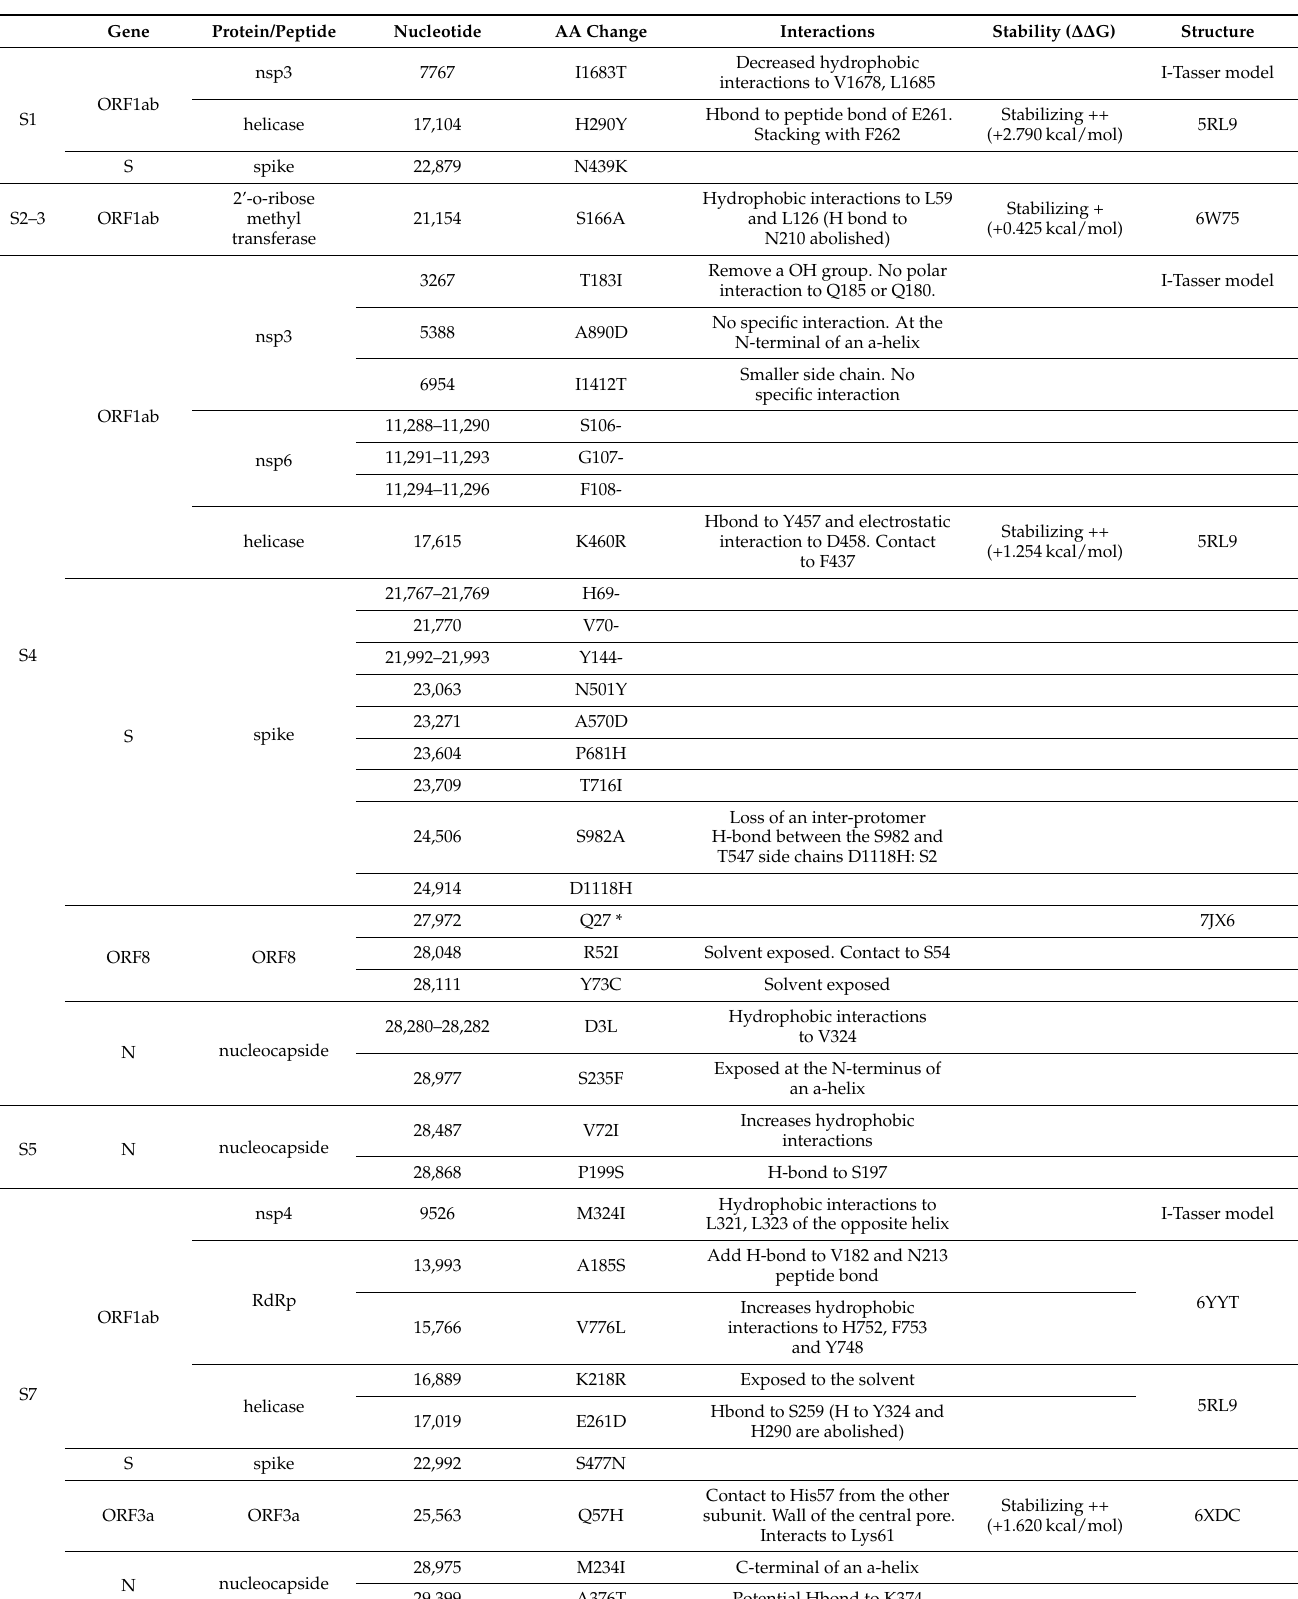
Table 3. Impact of mutations on protein conformation and